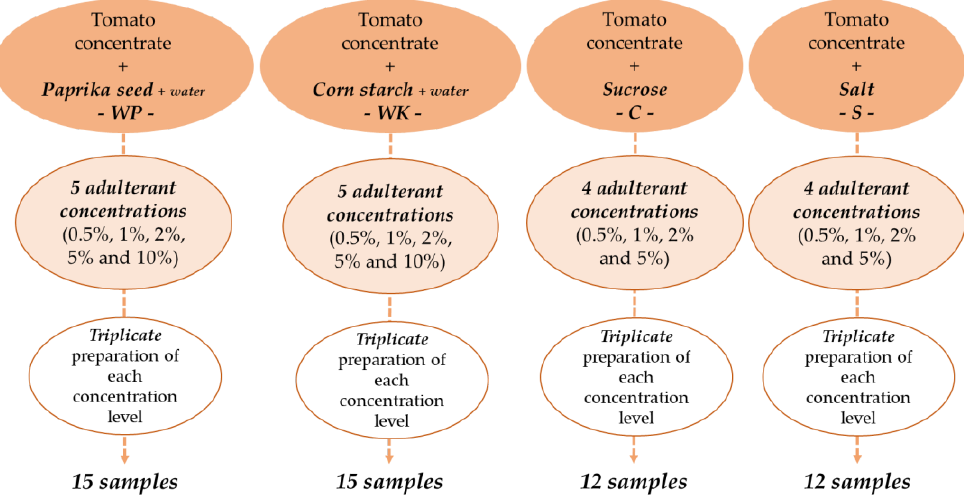
Figure 1. Preparation of adulterated tomato paste samples.